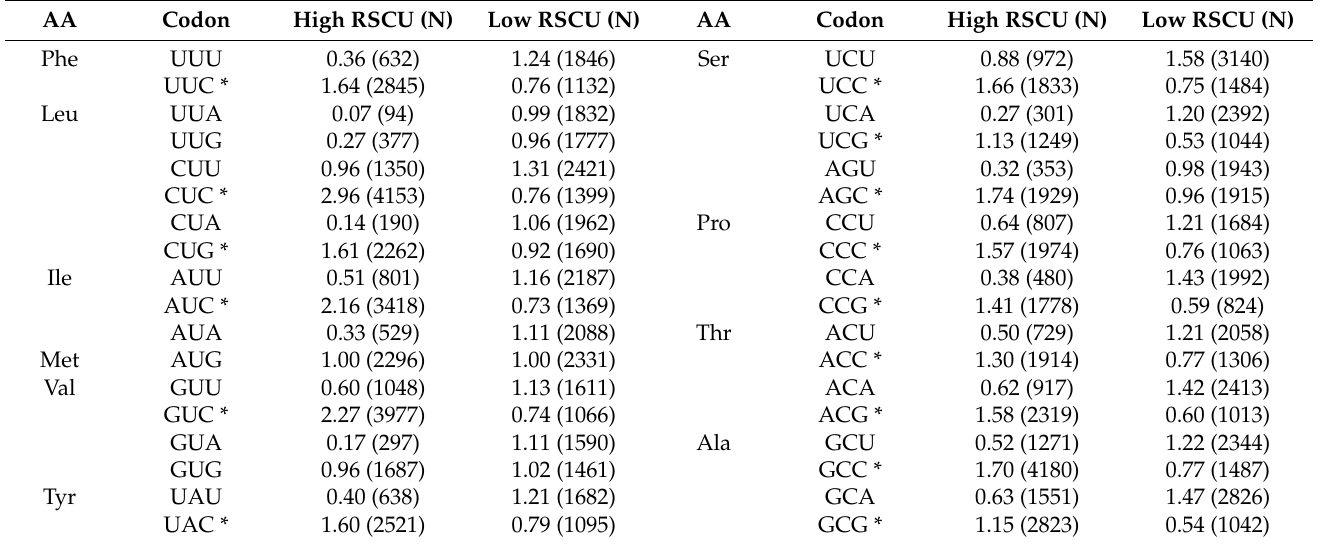
Table 4. Translational optimal codons of G. duodenalis